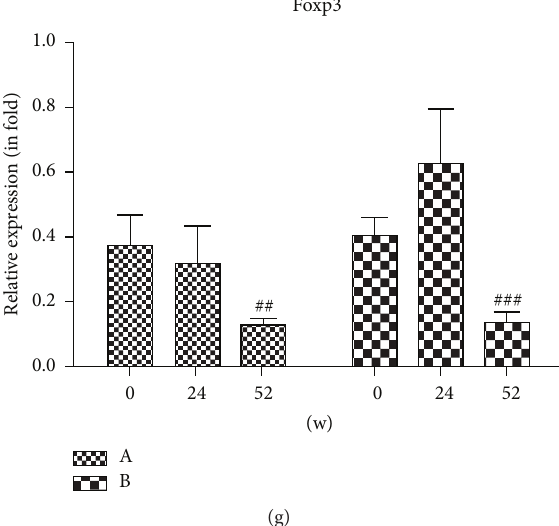
Figure 4: Changes of the expression of Th1/Th17/Tfh/Treg related transcriptional factors at mRNA levels in RA patients before and after therapy. Relative expression of (a) T-bet, (b) IL-17, (c) ROR 𝛾 t, (d) STAT3, (e) Bcl6, (f) IL-21, and (g) Foxp3. Mean mRNA expressions of cytokines and transcription factors in our study were quantified by RT-PCR and are statistically significant compared to 24 w ( ∗ 𝑝 < 0.05 , ∗∗ 𝑝 < 0.01 , or ∗∗∗ 𝑝 < 0.001 ). # 𝑝 < 0.05 , ## 𝑝 < 0.01 , and ### 𝑝 < 0.001 are statistically significant compared to 0 w. Group A: iguratimod was administered to patients for 52 weeks. Group B: placebo was administered to patients for the first 24 weeks and iguratimod was administered to patients for the subsequent 28